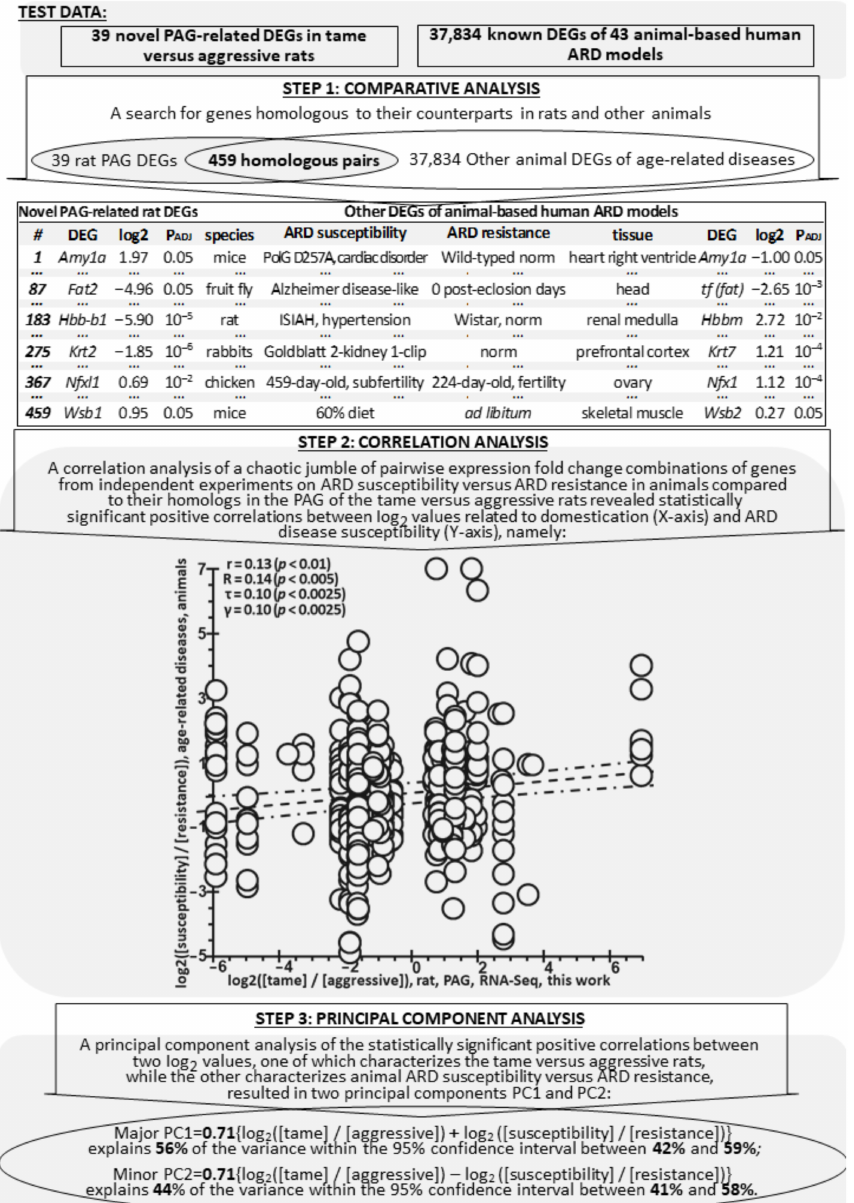
Figure 2. Comparison of the novel DEGs in the PAG of the tame and aggressive rats with the known DEGs related to animal ARD susceptibility and resistance. Legend: See the legend to Figure 1 and the footnote to Table 4; the x - and y -axes correspond to columns iii and x of Table S1; circles correspond to rows of Table S1; R, τ , and γ are the coefficients of Spearman’s rank correlation, Kendall’s rank correlation, and the Goodman–Kruskal generalized correlation, respectively, calculated using STATISTICA (Statsoft TM , Tulsa, OK, USA); PC1 and PC2: principal components calculated in the bootstrap-based refinement mode of the PAST4.04 software